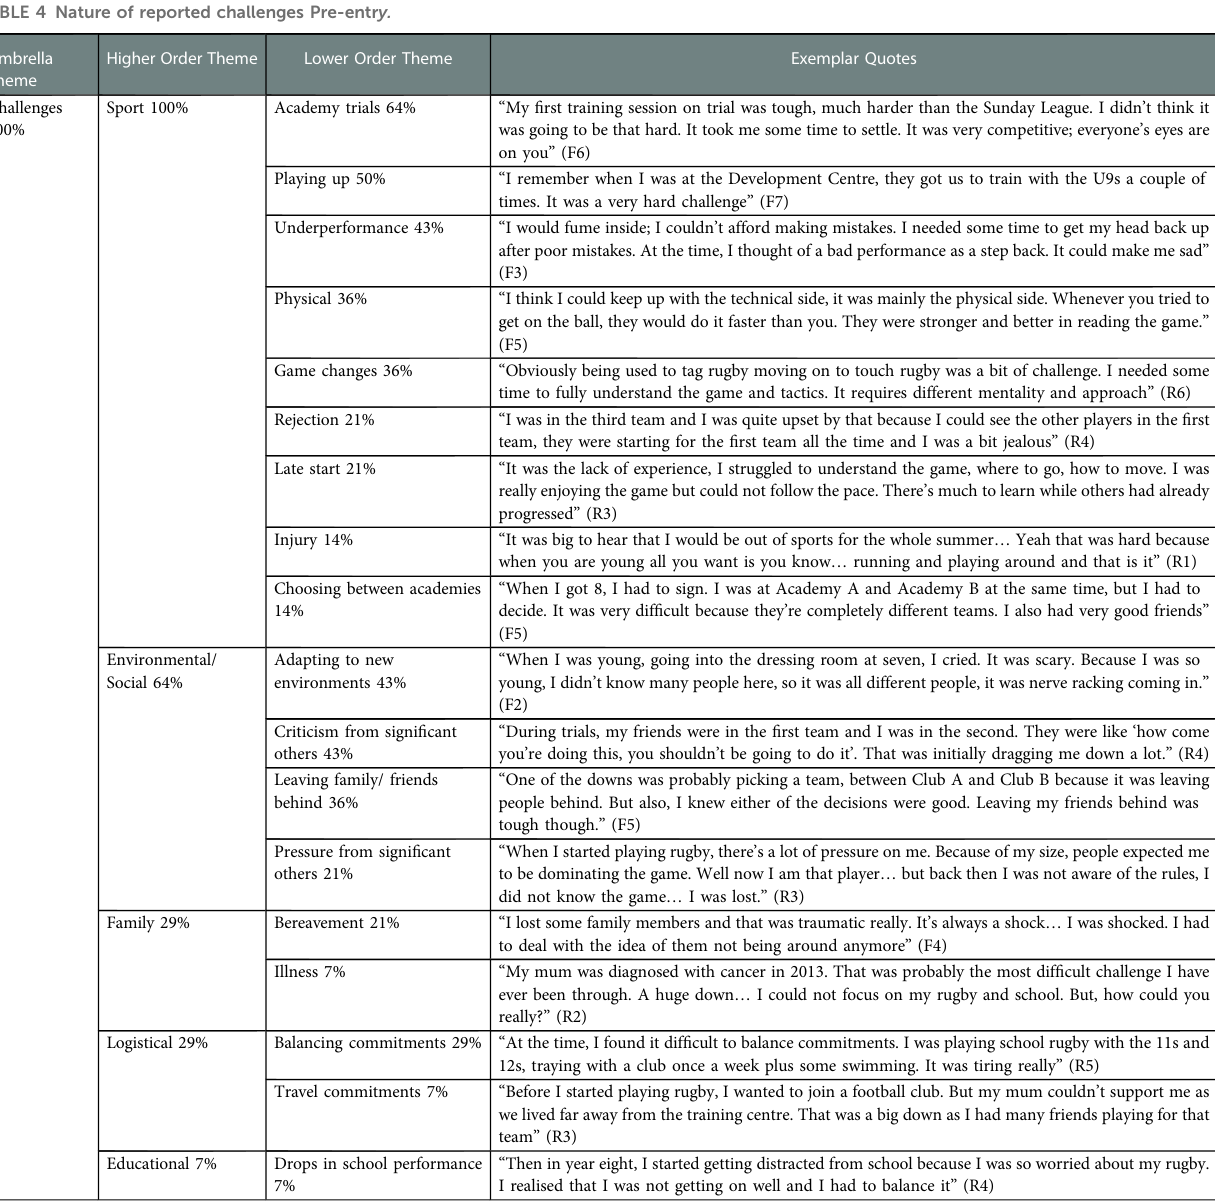
TABLE 4 Nature of reported challenges Pre-entr